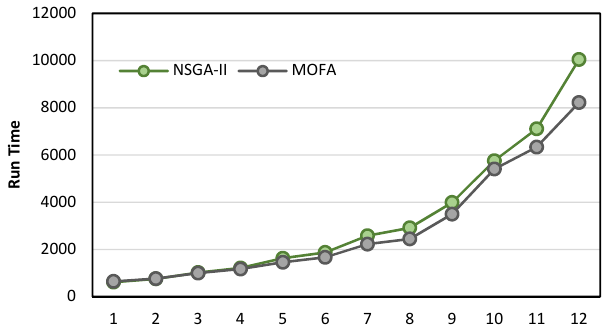
Figure 11. NSGA-II vs. MOFA in terms of solution time.